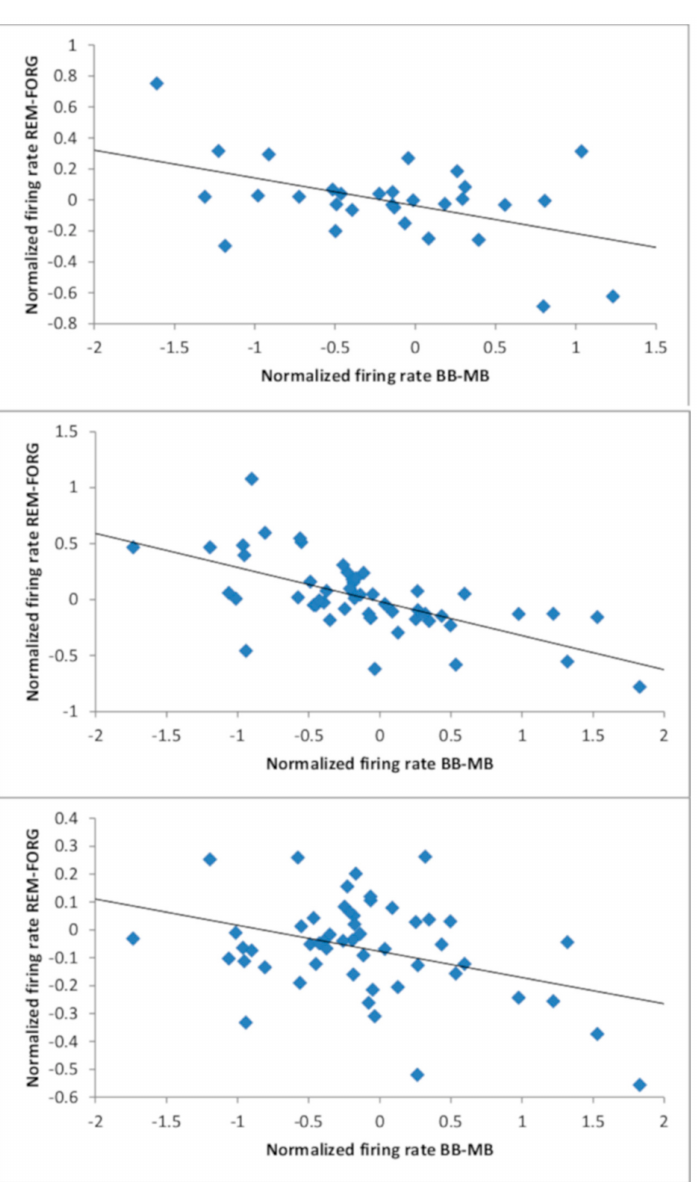
Figure 3. Correlation between beat stimulation-related and memory-related firing rate differ- ences on the left hemisphere: Top: Encoding phase; item memory; 1500–2000 ms window; r = − 0.47 ( p = 0.009). Middle: Retrieval phase; item memory; 1000–1500 ms window; r = − 0.64 ( p = 4 × 10 − 7 ). Bottom: Retrieval phase; source memory; 1000–1500 ms window; r = − 0.38 ( p =